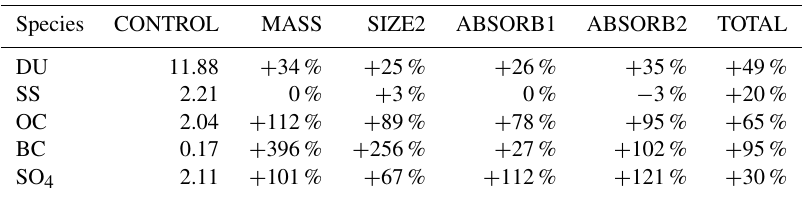
Table 3. Global column burden (Tg) of all aerosol species regarding the CONTROL experiment and the induced percentage changes due to assimilation for the MASS, SIZE2, ABSORB1 and TOTAL